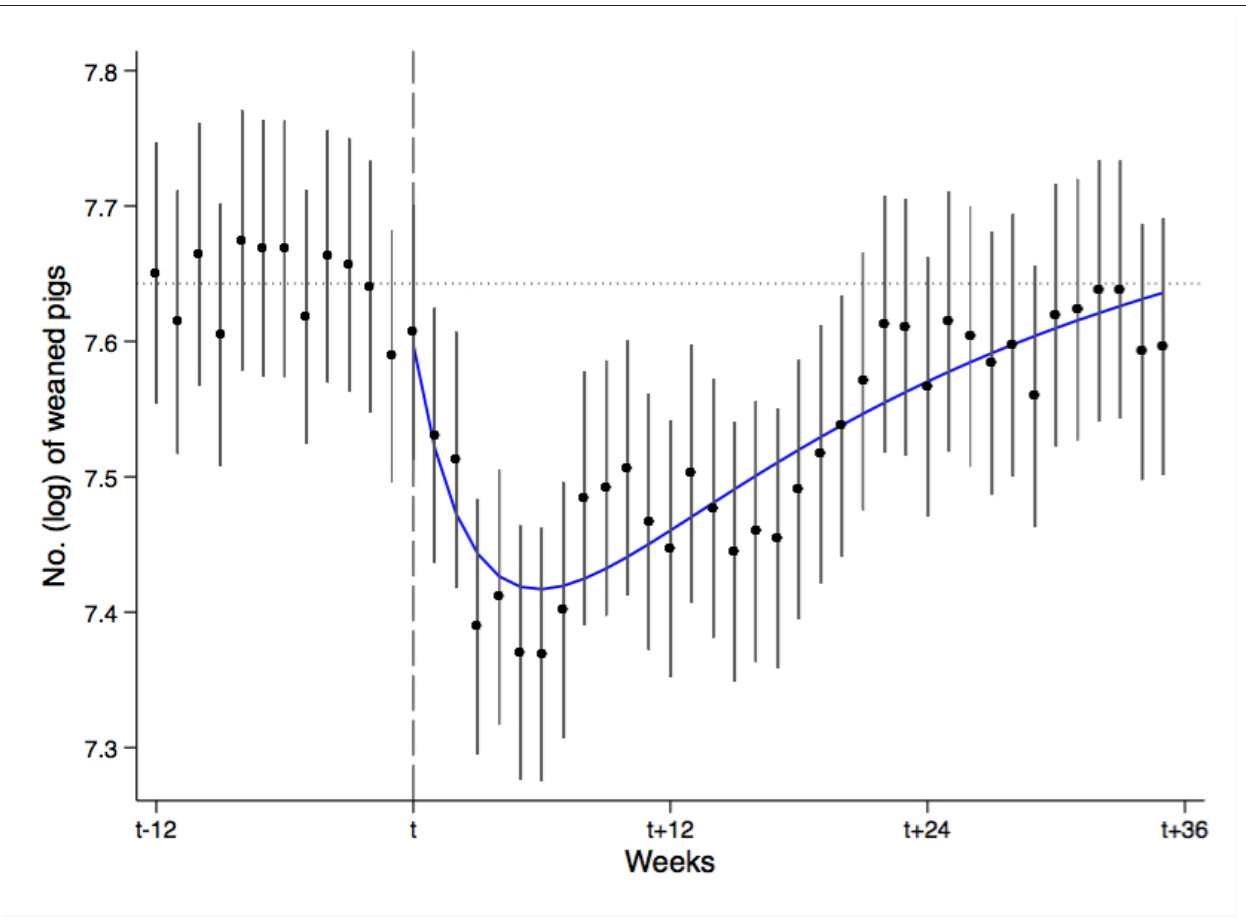
FigUre 3 | Means of fitted number (log) of weaned pigs during pre- and post-outbreak period ( table s2) . The horizontal dotted line shows the estimated overall baseline of production ( Table 1 ). The smooth blue line shows a 4th degree polynomial function that fits estimated means of number (log) of weaned pigs each week during the post-outbreak period ( t to t + 35). Vertical lines indicate 95% confidence